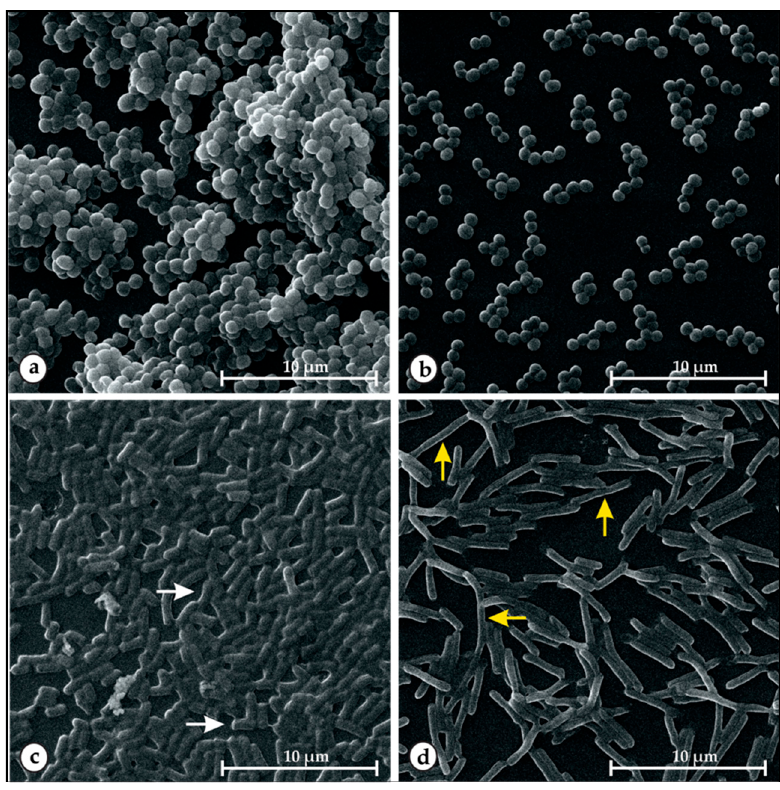
Figure 4. Scanning electron microscopy images of preformed biofilms of S. aureus (5B) and E. coli (P12) treated with the EO of Ocimum gratissimum L. (EOOG) at MIC doses. Untreated 5B ( a ) and P12, ( c ) and EOOG-treated 5B, ( b ) and P12 ( d ) cells. In the control condition, E. coli presented rod-shaped (white arrow) cells, and after EOOG treatment, the P12 cells displayed an elongated (yellow arrow) morphology status.